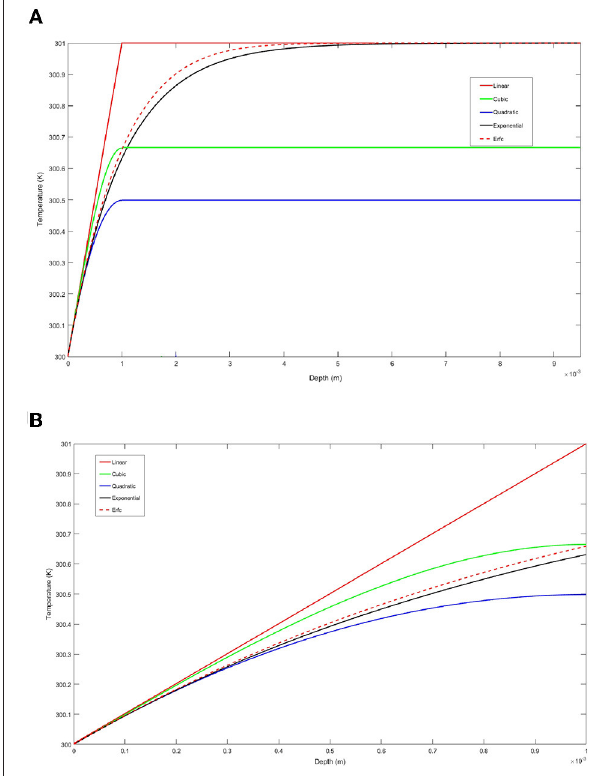
FIGURE 7 | Model temperature distributions (thermal stratification) for constant surface heat flux condition with q k 1 T d 608 Wm − 2 . All of the = = curves have the same slope, 1 T/d, at y 0. The exponential and Erfc curves in = (A) asymptote to T d 301K with the domain of the depth set at y 9.25 = = × 10 − 3 m which is the location where the exponential curve attains 99.99% of T d . For the cubic and quadratic models, the edge of the thermal boundary layer is treated as if it occurs at y 1 10 − 3 m, with the cubic reaching T = × = 300.667K and the quadratic T 300.500K. (B) is an exploded view of the = thermal boundary layer, left hand side of (A)